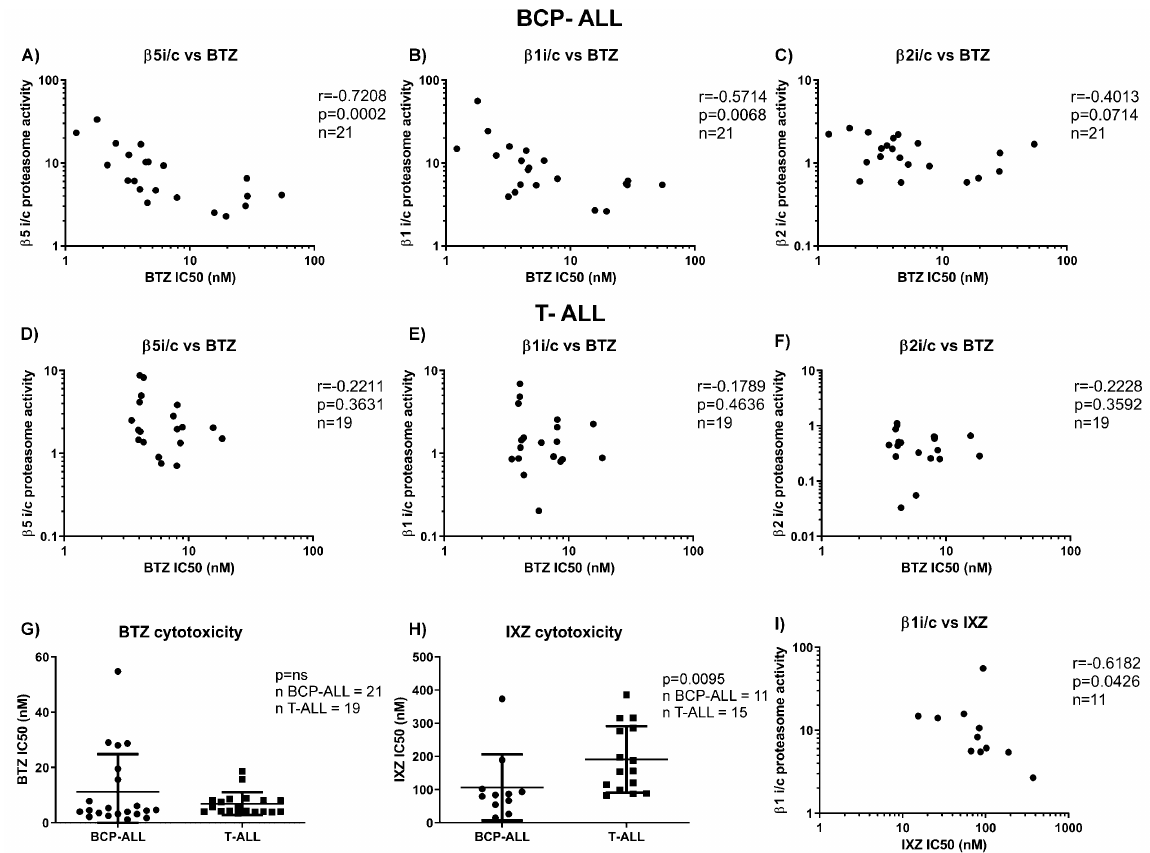
Figure 2. Correlation between the BCP-ALL and T-ALL samples and the cytotoxicity of bortezomib and ixazomib. Correla- tion between the ratio of activity of proteasome β 5i versus β 5c ( A ), β 1i versus β 1c ( B ) and β 2i versus β 2c ( C ) proteasome subunits, determined by ABPs, and cytotoxicity of BTZ in BCP-ALL, expressed as individual IC 50 values. r and p were obtained with Spearman’s correlation. Correlation between the ratio of activity of proteasome β 5i versus β 5c ( D ), β 1i versus β 1c ( E ) and β 2i versus β 2c ( F ) subunits, determined by ABPs, and cytotoxicity of BTZ in T-ALL, expressed as individual IC 50 values. r and p were obtained with Spearman’s correlation. ( G ) Comparison of the IC 50 values for BTZ between BCP-ALL and T-ALL samples. p was obtained with Mann–Whitney U test. ( H ) Comparison of the IC 50 values for IXZ between BCP-ALL and T-ALL samples, p was obtained with Mann–Whitney U test. ( I ) Correlation between the ratio of activity of proteasome β 1i versus β 1c proteasome subunits, determined by ABPs, and cytotoxicity of IXZ in BCP-ALL, expressed as individual IC 50 values. r and p were obtained with Spearman’s correlation. BTZ = bortezomib, IXZ = ixazomib, BCP-ALL = B-cell precursor acute lymphoblastic leukemia, T-ALL = T-lineage acute lymphoblastic leukemia, i = immunoproteasome, c = constitutive